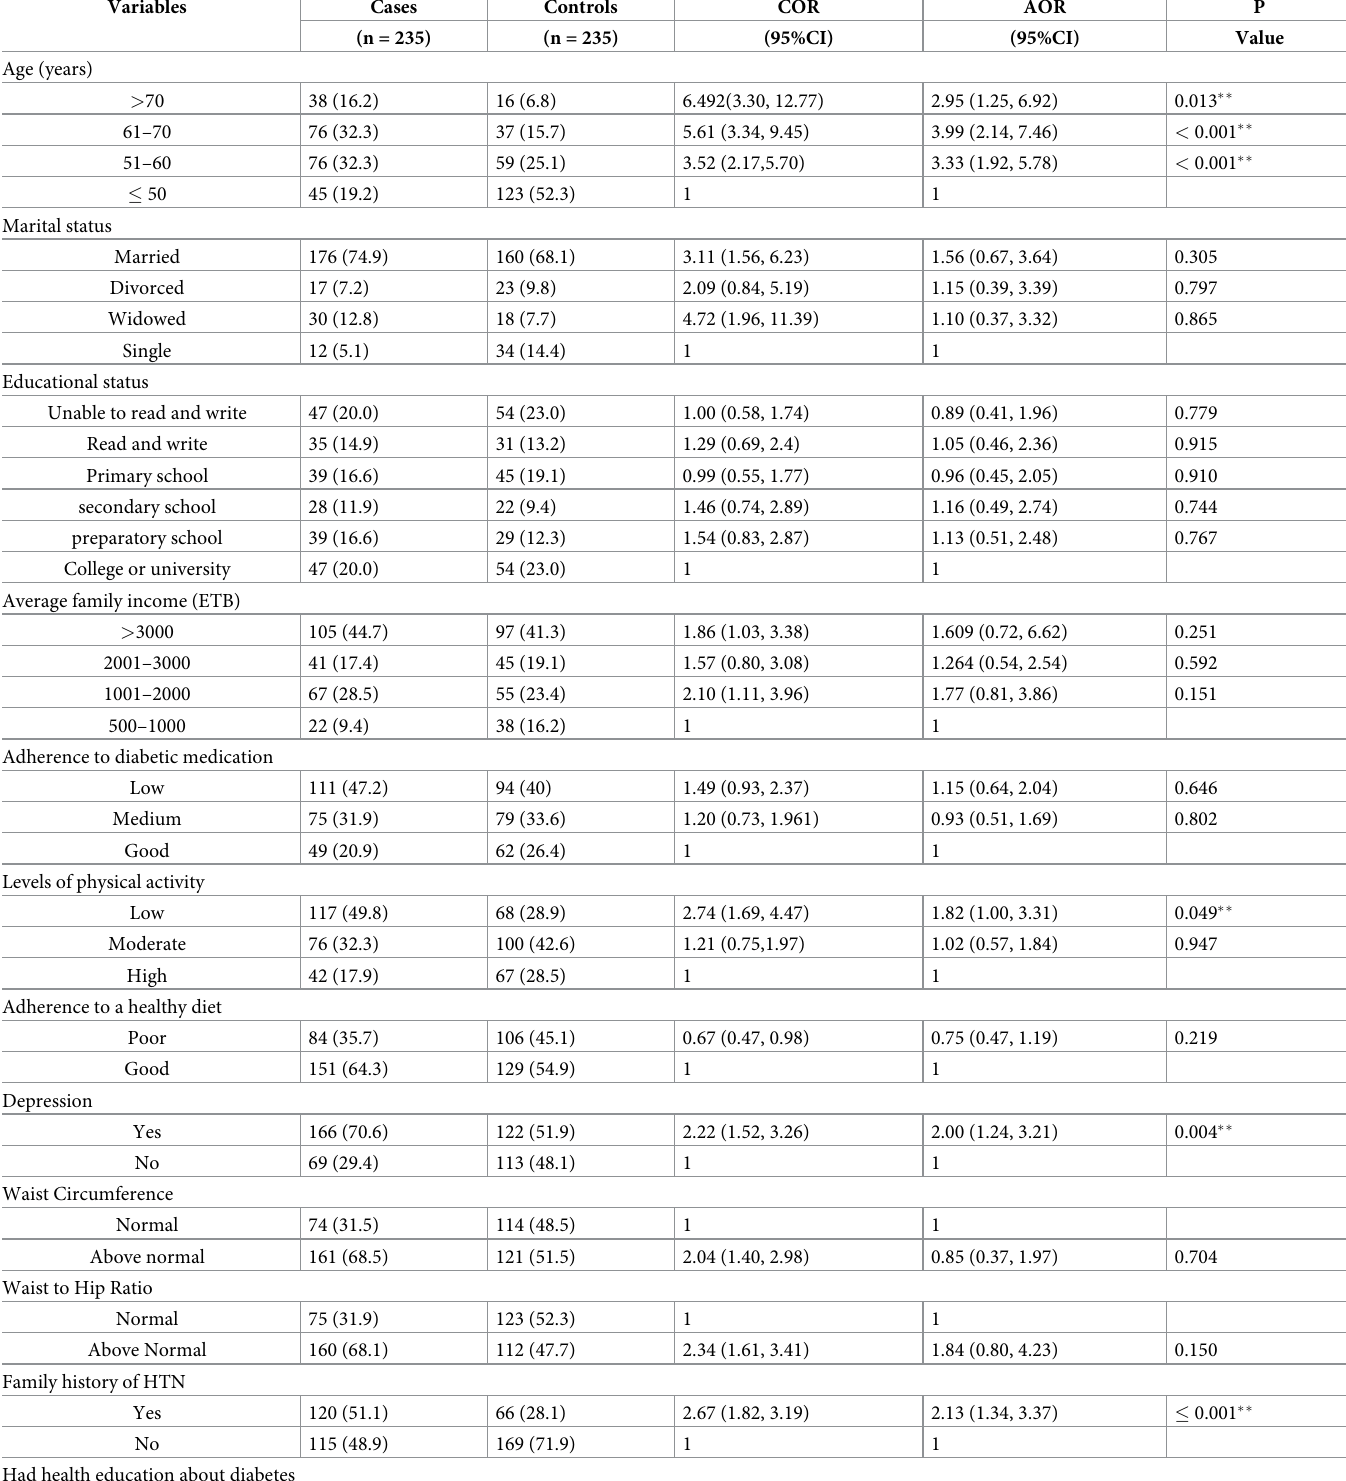
Table 4. Bivariate and multivariable logistic regression analysis